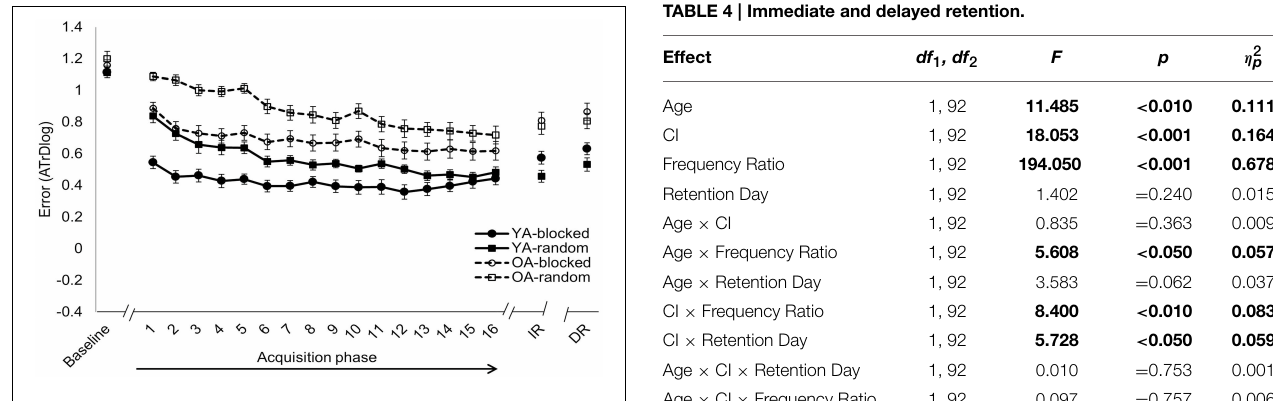
FIGURE 5 | Non-isofrequency ratios. Error score (ATrD, i.e., the log-transformed average track deviation) for baseline, acquisition phase (TR1-16), immediate retention (IR) and delayed retention (DR; mean ± standard error). Within each age group, i.e., younger adults (YA-solid line) and older adults (OA-dashed line), the task was practiced following either a blocked (circles) or random (squares) practice schedule. Better performance is indicated with lower levels of ATrDlog. Performance of OA was significantly lower than performance of YA during the acquisition ( p < 0 . 001 , Tukey HSD) and retention ( p < 0 . 001 , Tukey HSD) phase. Random practice resulted in inferior performance compared to blocked practice during the acquisition phase ( p < 0 . 001 ). This effect was mainly driven by performance differences at initiation of practice ( p < 0 . 001 , Tukey